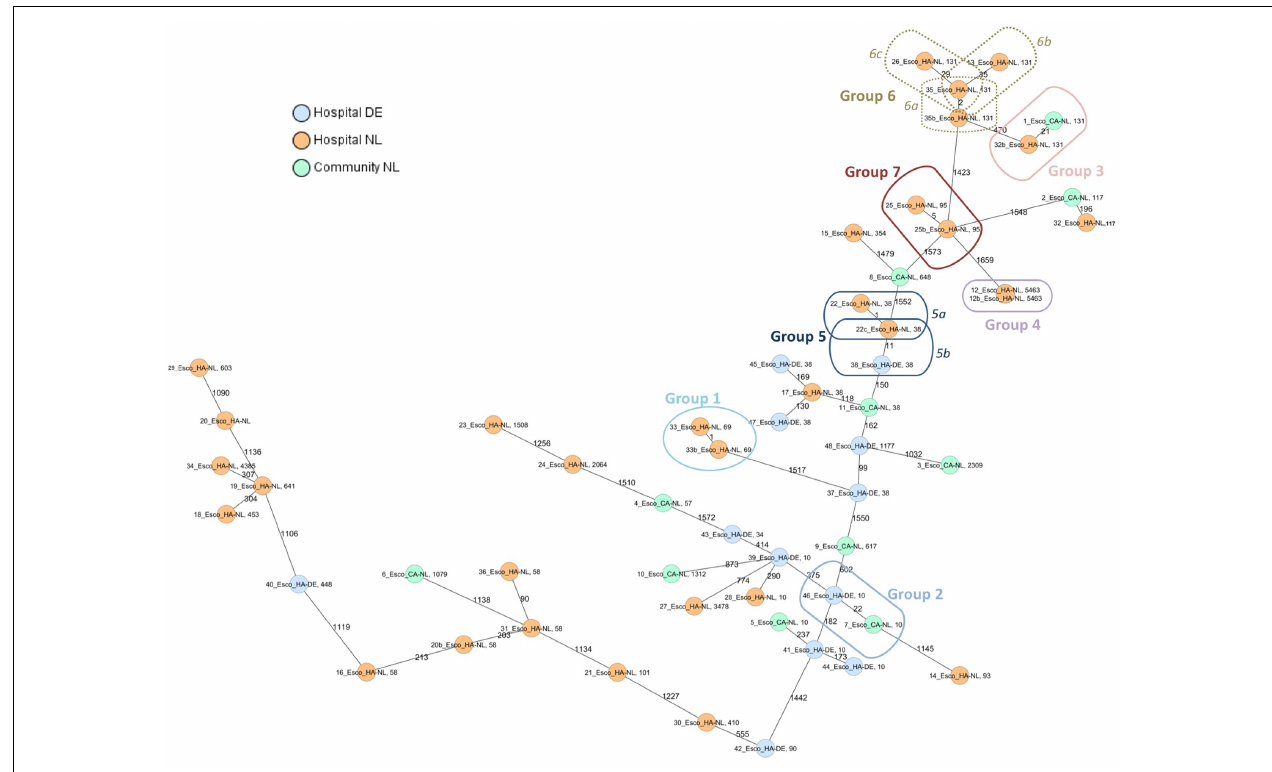
FIGURE 1 | Minimum spanning tree of ESBL- E. coli isolates from hospitals and the community. Distance based on a cgMLST of 1771 genes using the parameters “pairwise ignoring missing values” during calculation. Each circle represents a genotype, colors indicate geographical origin and community or hospital. Orange: hospital—Netherlands; blue: hospital—Germany; green: community—Netherlands. Number of different alleles are indicated on the edges between connected isolates (nodes). The cut-off values for defining a group was 35 alleles. Isolates are presented by their ID and